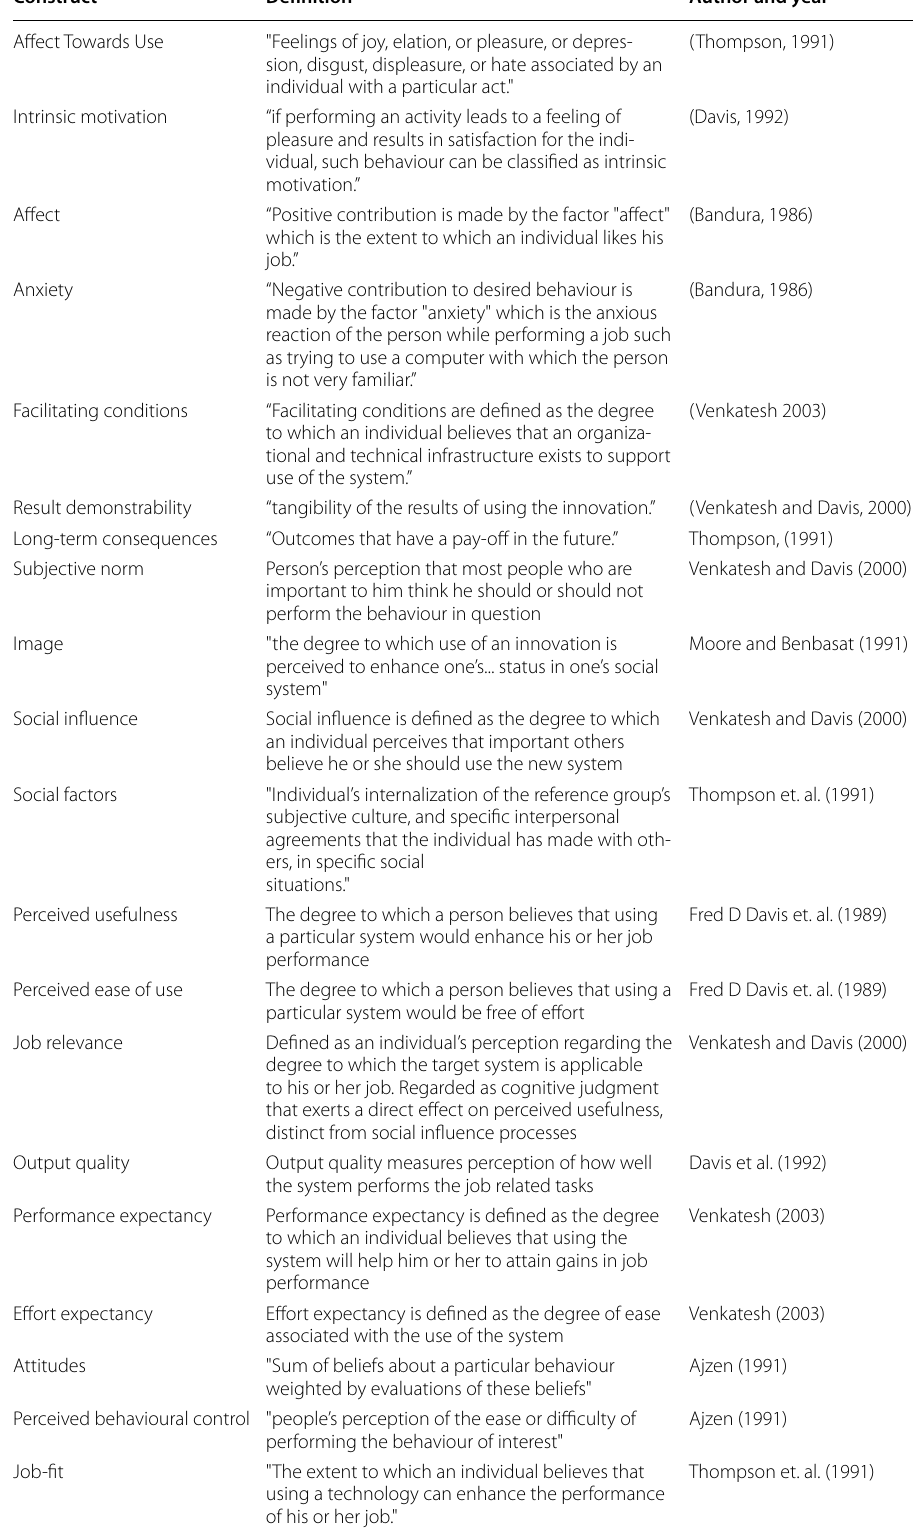
Table 10 Definition of the identified constructs in the technology adoption